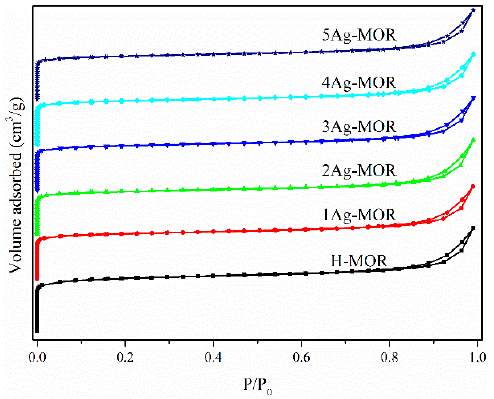
Figure 1. Ar adsorption–desorption isotherms of the catalysts.